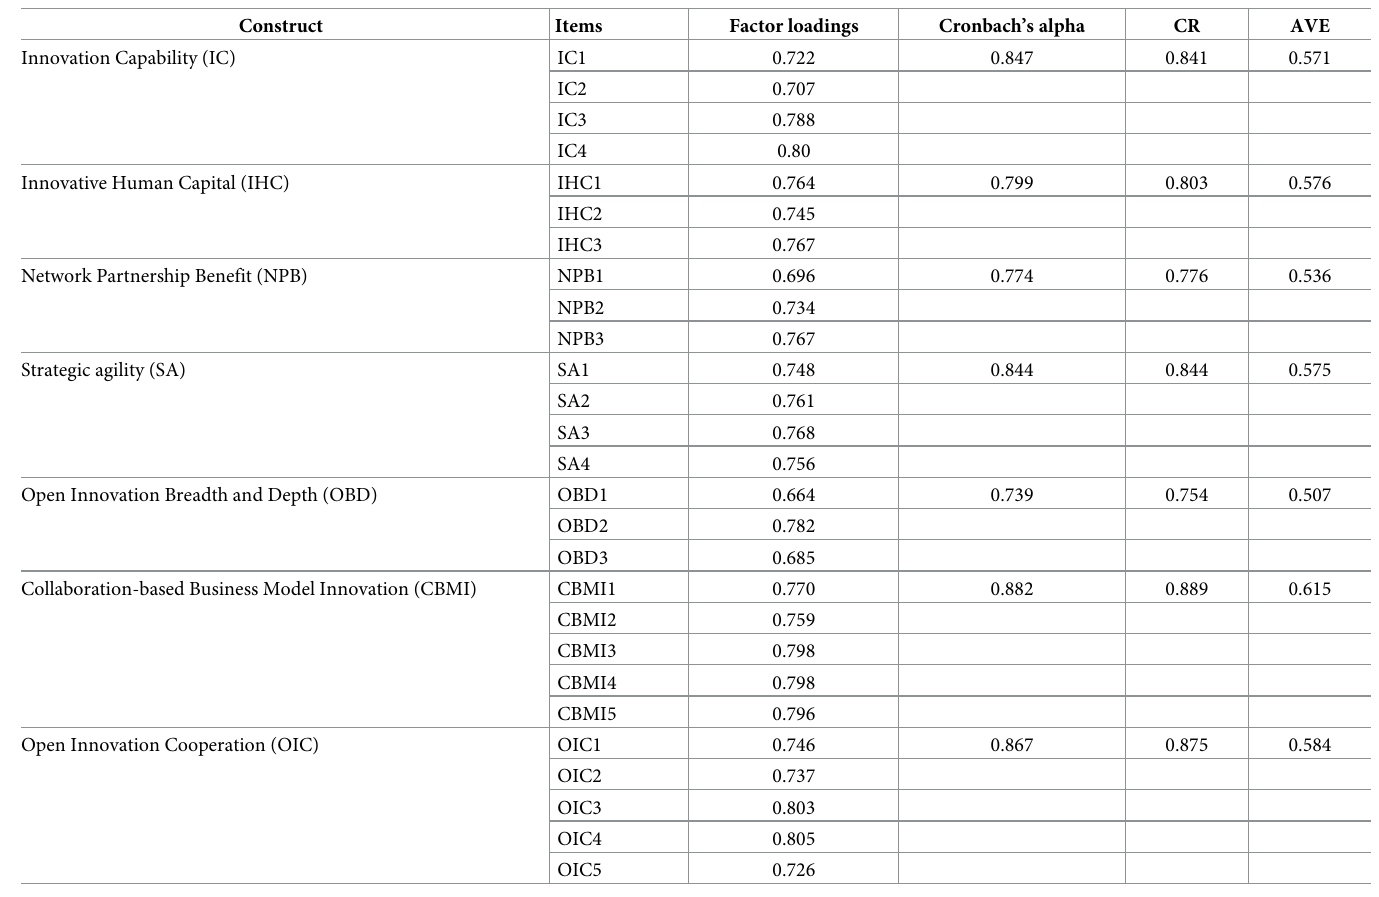
Measurement invariance analysis provides a guideline to determine if the measurement mod- els in the two groups are statistically different [81]. It was feasible to determine whether respondents from the two groups understood the underlying questions in the identical ques- tionnaires. According to the CFA model, the measurement invariance technique conducts the Table 3. Convergent validity and